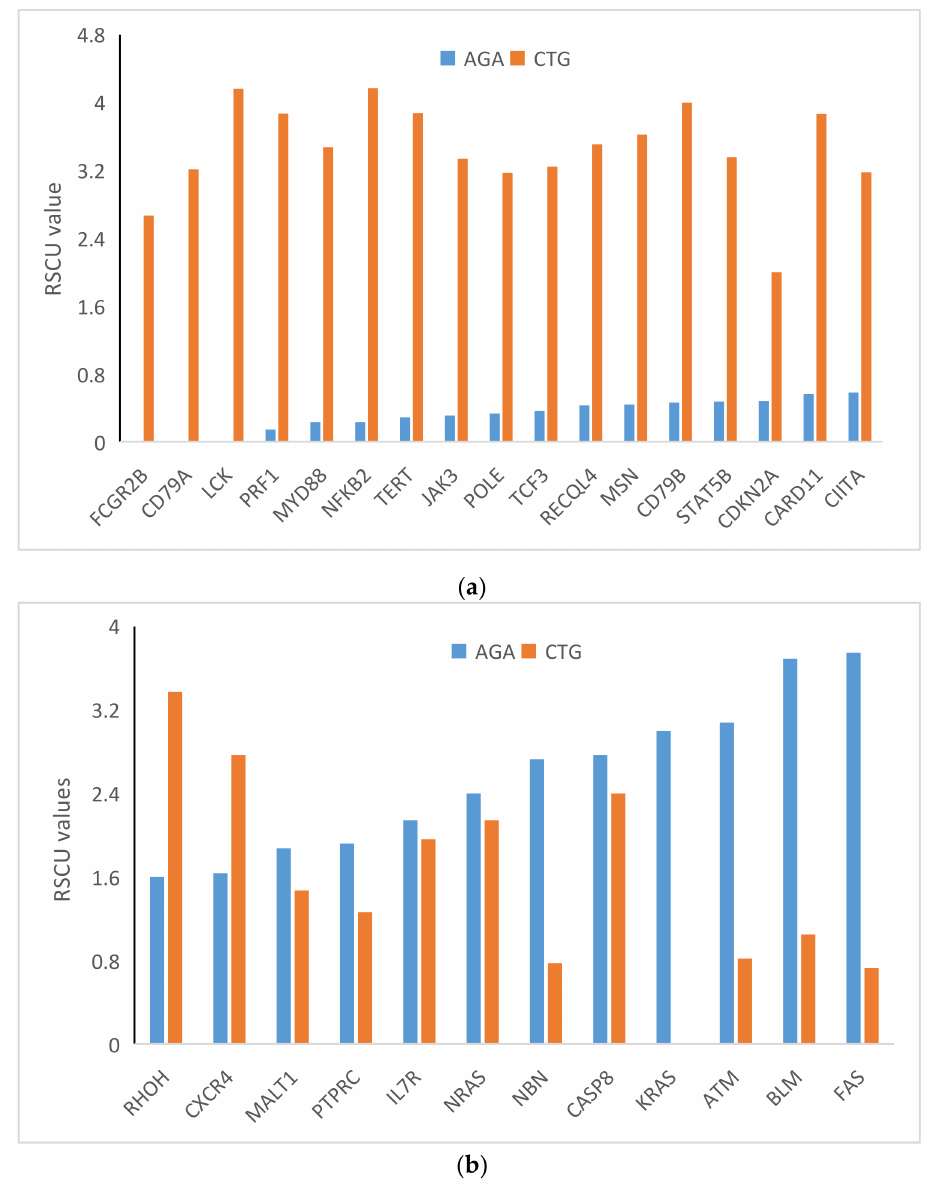
Figure 6. ( a ) Plot of under-represented AGA (RSCU values below 0.6) with corresponding CTG usage. ( b ) Plot of overrepresented AGA (RSCU > 1.6) with corresponding CTG